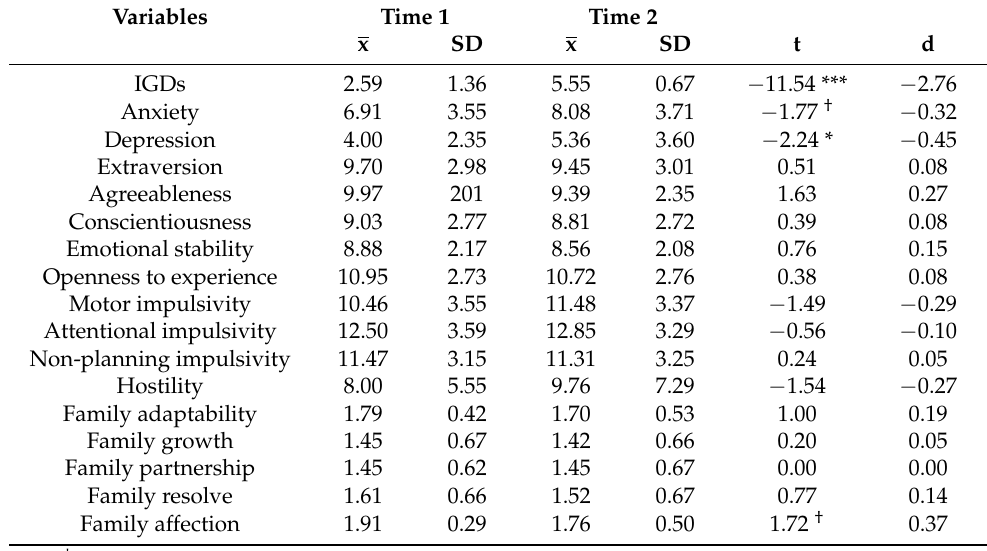
Table 3. Difference of means in the variables evaluated between T1 and T2 for the incidence group. Variables